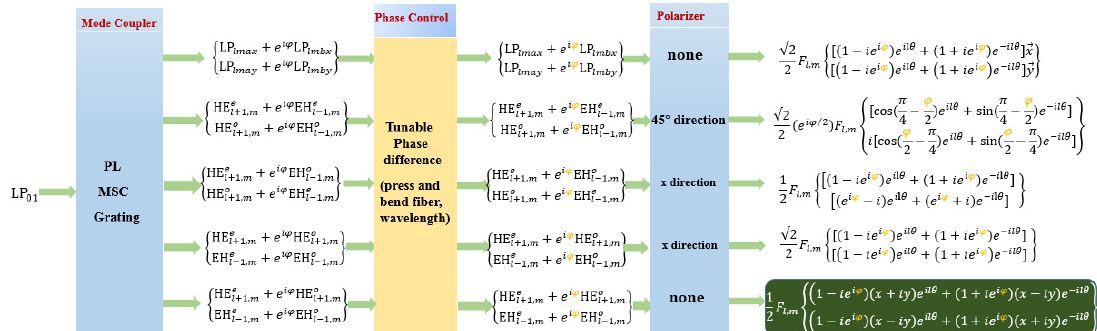
Figure 10. The flow chart of tunable OAM generation by adjusting the relative phase between two fiber modes.